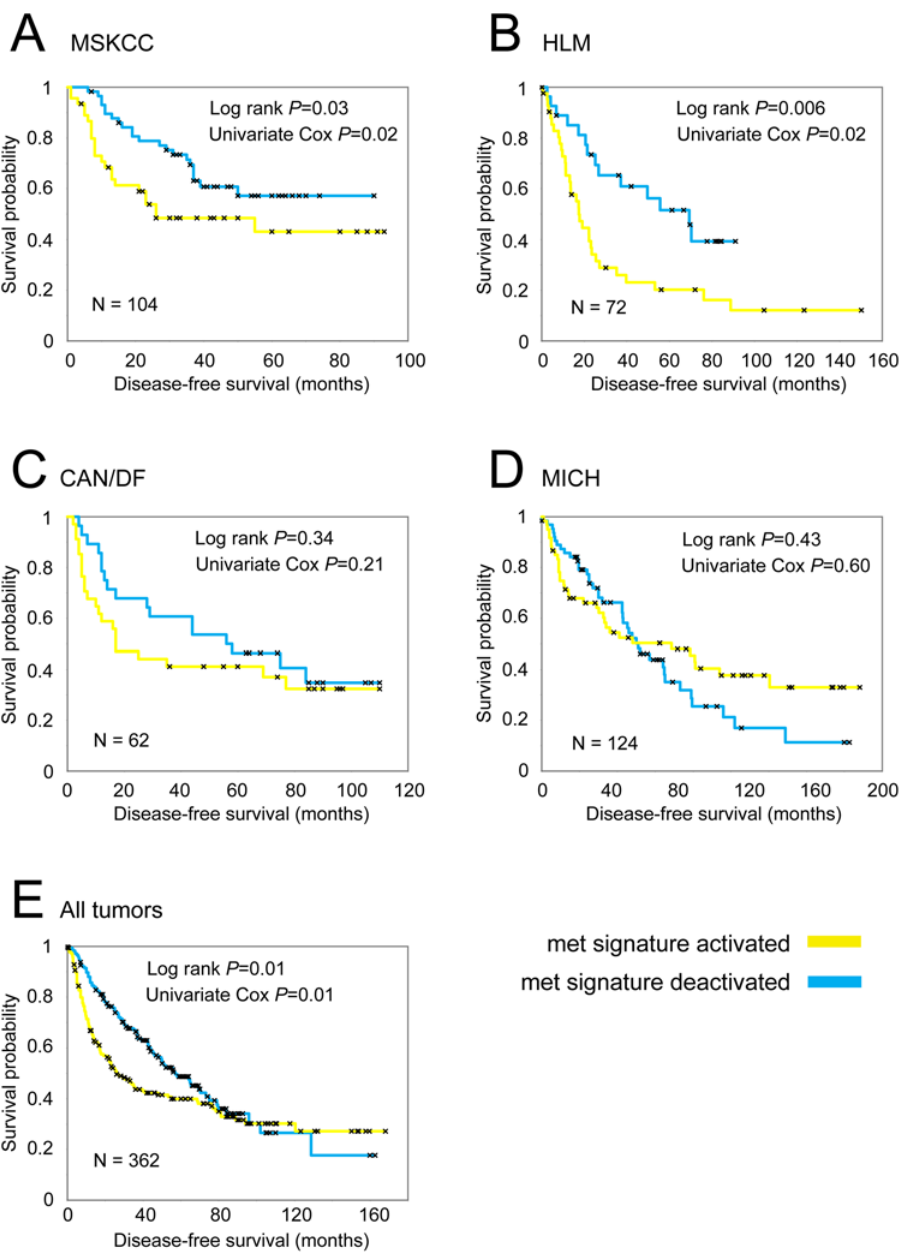
Figure 3. The spontaneous mouse metastasis signature is associated with poor prognosis in human lung tumor profile datasets from the Director’s Challenge Consortium. Kaplan-Meier analysis comparing the differences in risk between human lung tumors showing activation (yellow line, t-score . 0) and tumors showing deactivation (blue line, t-score , 0) of the mouse model metastasis signature. Datasets from the study by Shedden et al. [15] and represent four independent cohorts from (A) Memorial Sloan-Kettering Cancer Center (MSK), (B) Moffitt Cancer Center (HLM), (C) Dana-Farber Cancer Institute (CAN/DF), and (D) University of Michigan Cancer Center (MICH). (E) Kaplan-Meier analysis of tumors combined from all four datasets (N=362).